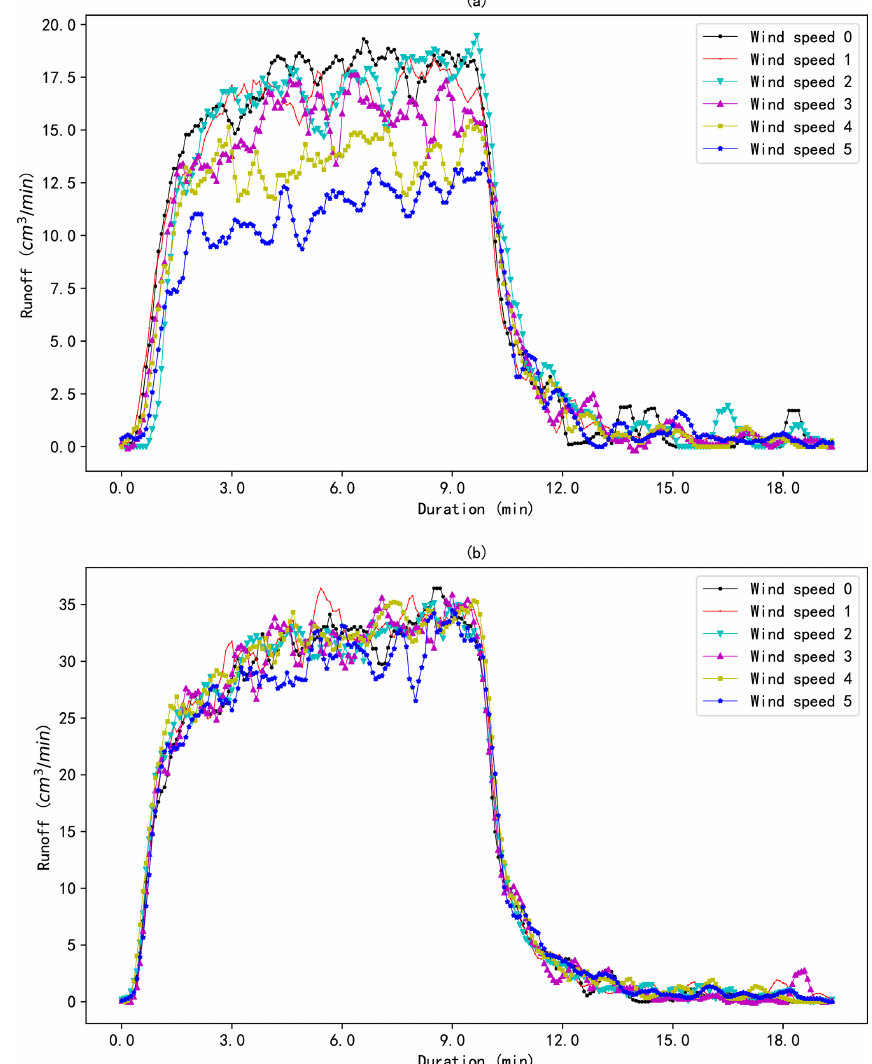
Figure 4. The hydrographs of the runoff of the scale model for different wind speeds under rainfall types 1 (a) and 2 (b)